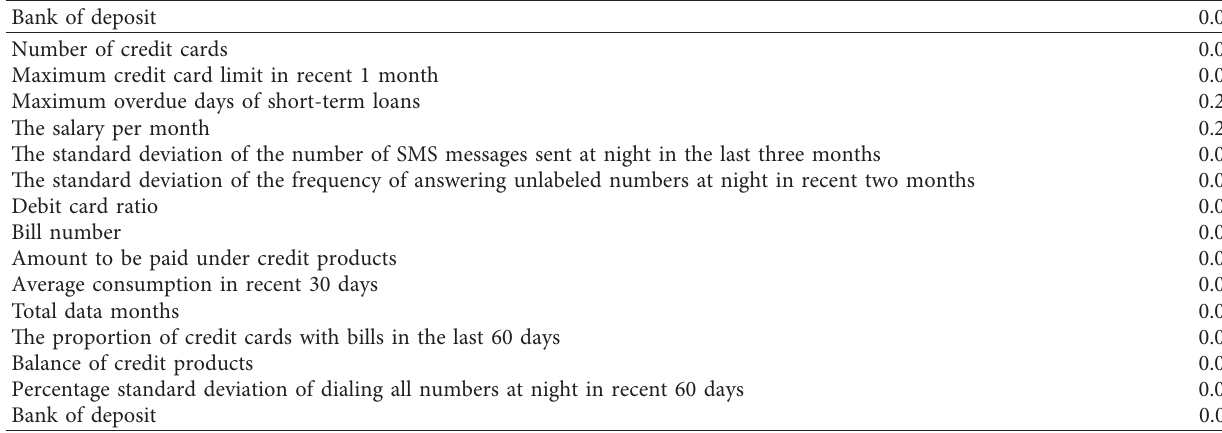
Table 6: Variables selected into the model.